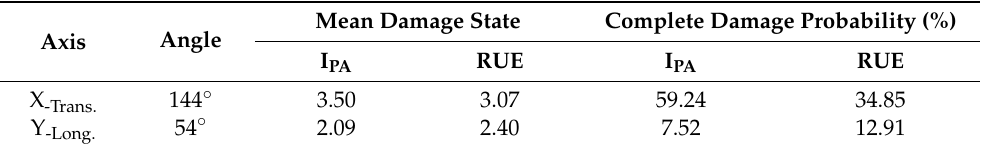
Table 5. Mean damage state and complete damage probability in the main axes of the building based on the proposal of the Risk- UE project and, the Park and Ang damage index.